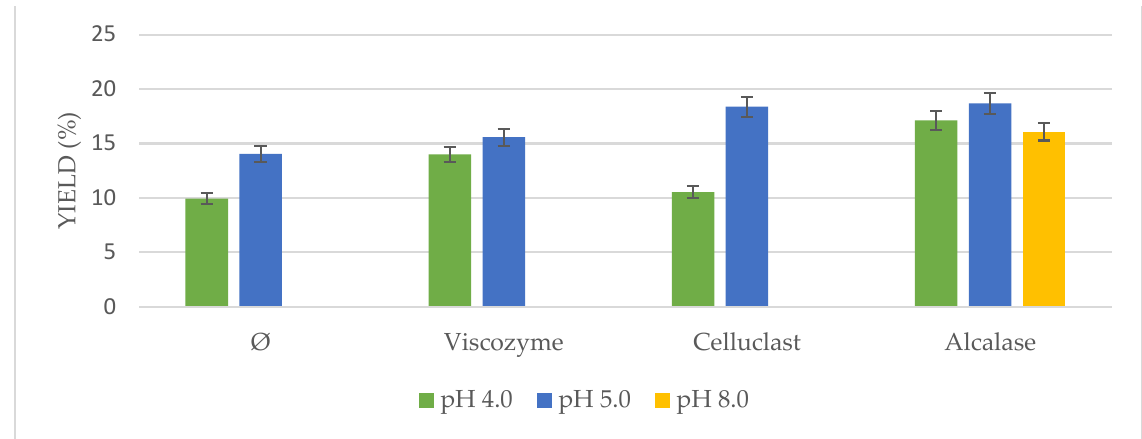
Figure 4. Nannochloropsis gaditana oil yield obtained by ultrasound-assisted enzymatic pretreatment at different pH (4, 5, and 8).